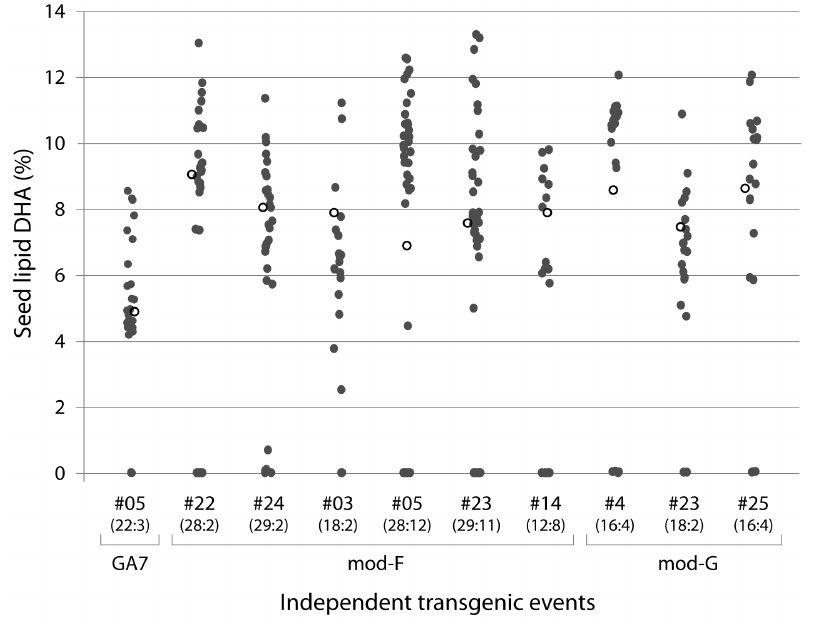
Figure 3. Relative level of DHA (as % of total fatty acids) in single seeds from independent T 2 Camelinasativa events. The transgenic to null ratio is shown in parenthesis under the event number (note that not all zero DHA seeds were null). Open circles denote the DHA level in a pooled batch of 20 seeds (analysed separately).